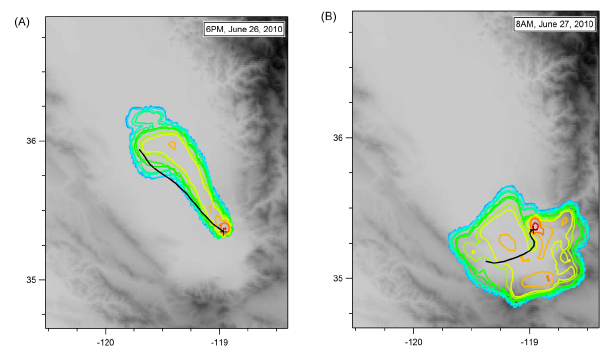
Figure 2. Examples of individual probability distribution back- trajectory footprints produced using FLEXPART-WRF (contours with log color scale – red: max, blue: min) for the southern San Joaquin Valley with air parcels arriving at the CalNex-Bakersfield ground site. Two examples show results for the previous 6 h with air parcels coming (A) along a concentrated northwest flowpath and (B) a more dispersed footprint from the southern tip of the valley. Dates and arrival times are superimposed on the panels. Also shown are comparisons of single-path HYSPLIT back-trajectories (black lines) and FLEXPART-WRF footprints. Figure 3. Concentrations of several compounds from Bakersfield,